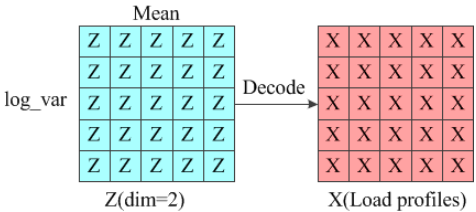
Figure 4. Visualization of latent vectors. Energies 2019 , 01 , x FOR PEER REVIEW